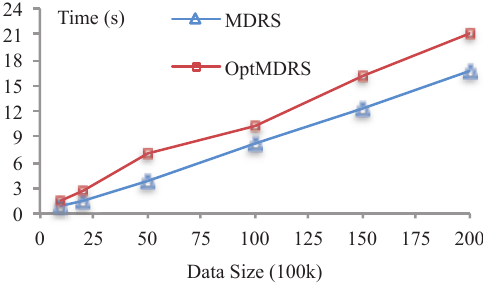
Fig. 4. Performance with increasing data set size.